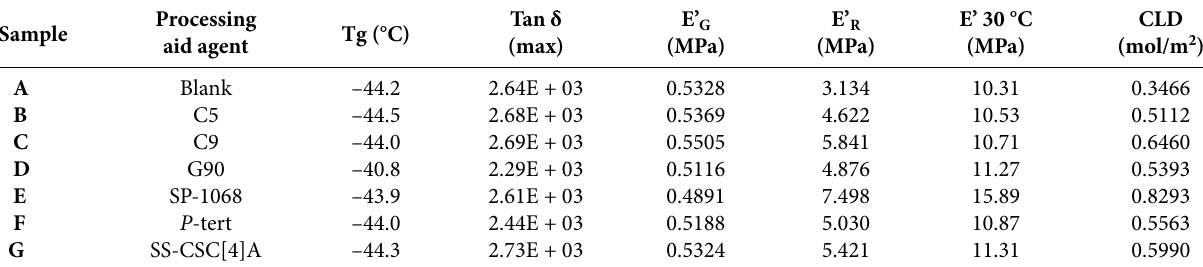
Table 5. The results of dynamic mechanical thermal properties of rubber compounds A-G.